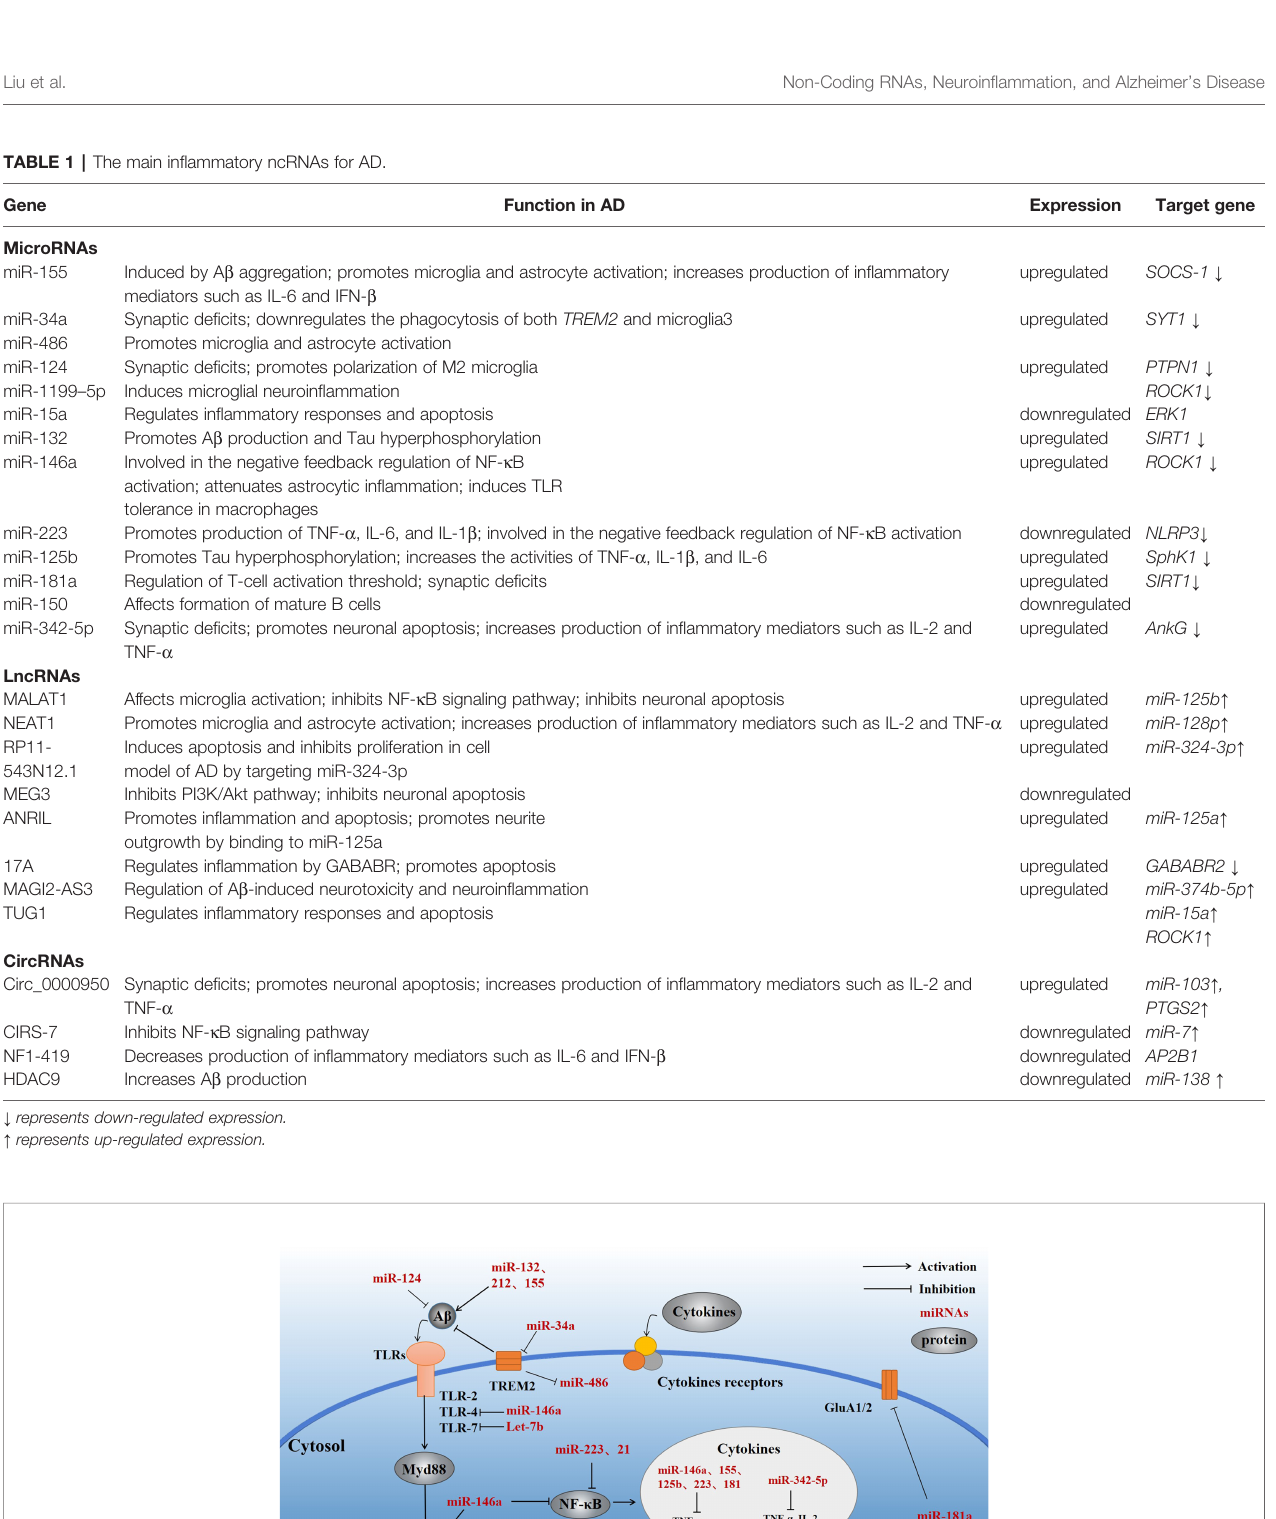
FIGURE 3 | Effect of in fl ammatory miRNAs on AD in fl ammation. Multiple in fl ammatory miRNAs may play a synergistic or antagonistic role in different in fl ammatory pathways. For example, mir-146a targets the MyD88-related pathway by binding to TLR-4. At the same time, NF- k B is inhibited, preventing release of in fl ammatory factors. Meanwhile, miR-155 and miR-181a regulate a variety of in fl ammatory mediators. Microglial activation is important in various in fl ammatory processes and is stimulated by miR-34a and miR-486. Apoptosis, as the terminal link in the in fl ammatory response, also plays a signi fi cant part in the progression of AD and is regulated by miR-150.